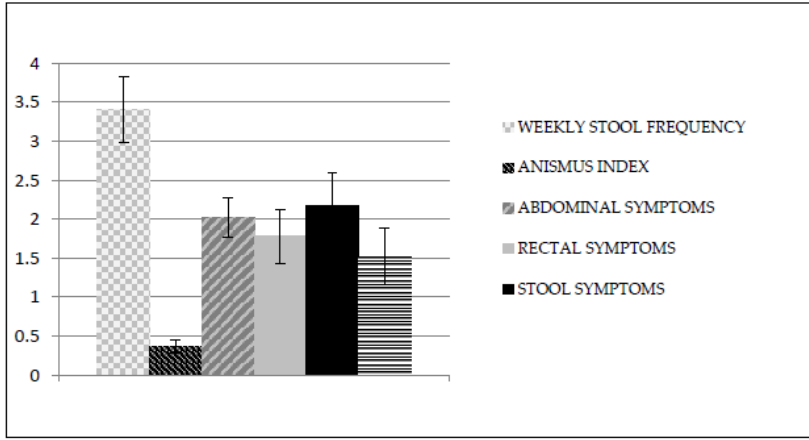
Figure 2. Mean values in all dependent measures after treatment in the EMG-biofeedback group.